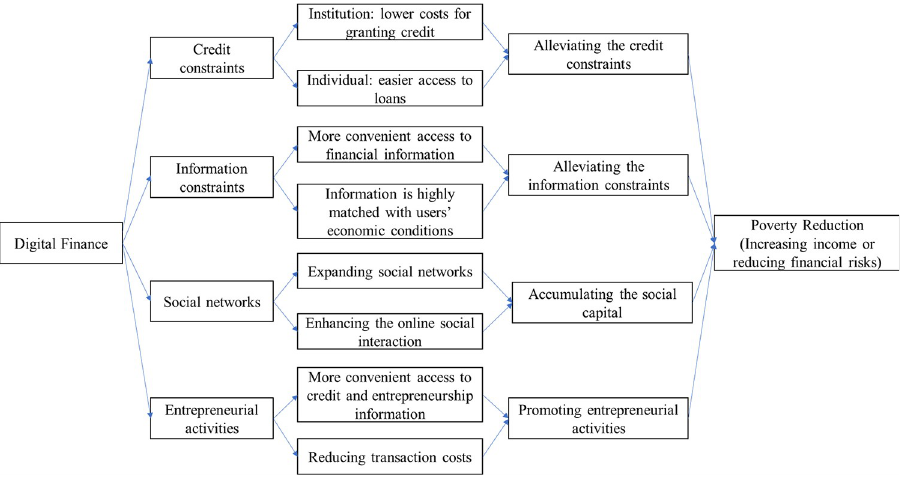
Fig 3. The mechanisms of digital finance on poverty